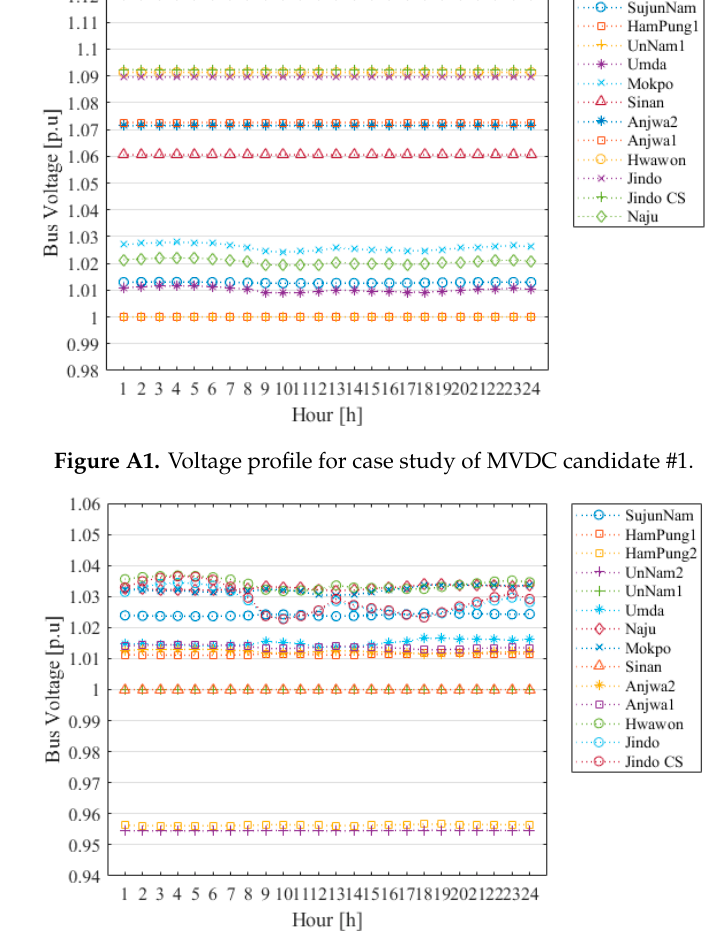
Figure A2. Voltage profile for case study of MVDC candidate